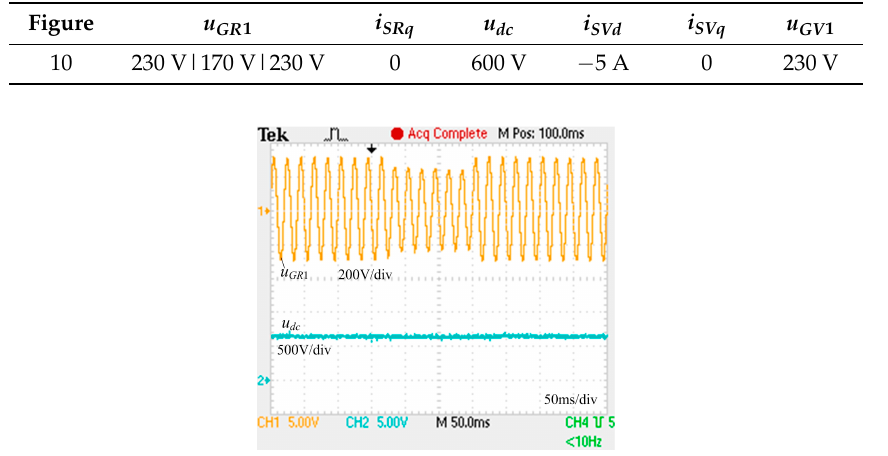
Figure 10. DC-bus voltage control experimental result, CH1: u GR 1 , 200 V/div; CH2: u dc , 500 V/div; 50